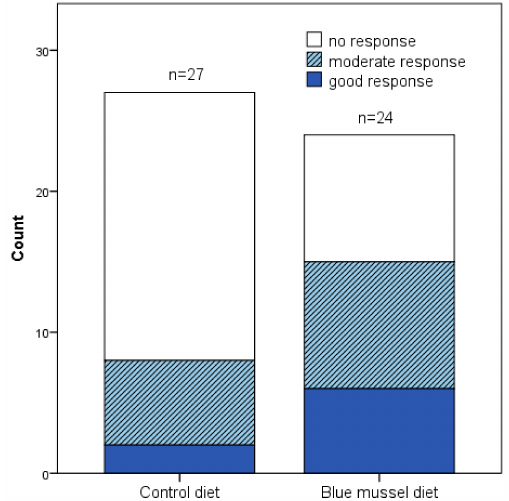
Figure 3. DAS28 EULAR-criteria response to blue mussel and control diet for all that completed at least one period. Pearson’s chi-square test for moderate, good or no response p = 0.049 and Fisher’s exact test p = 0.060 between the dietary periods. Control diet n = 27, blue mussel diet n =